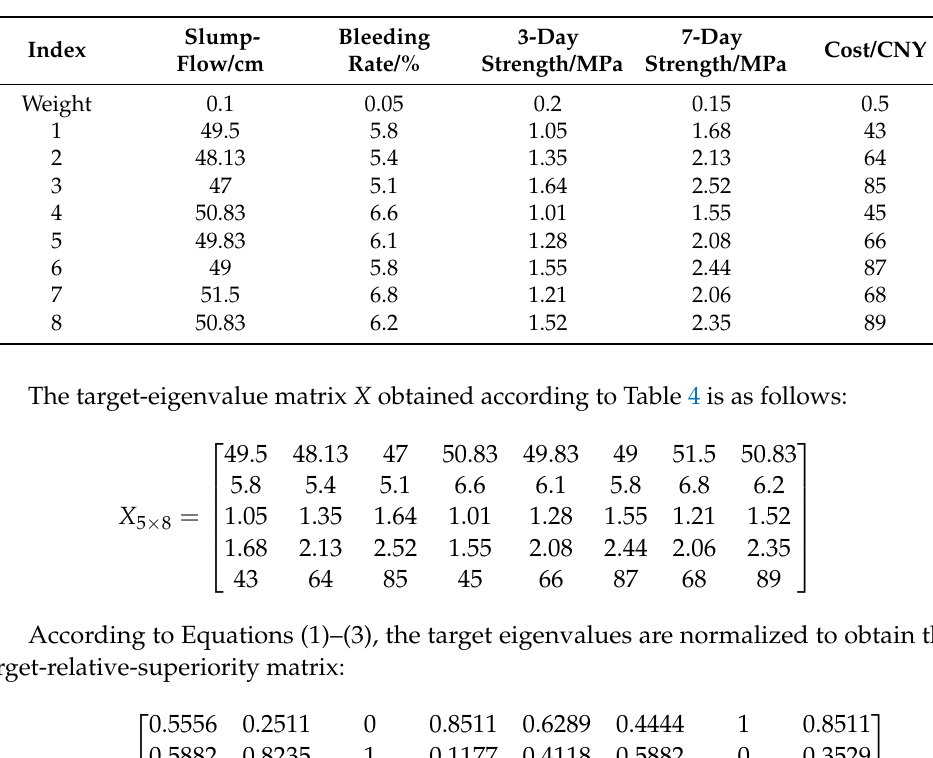
Table 4. Target eigenvalues of the alternative